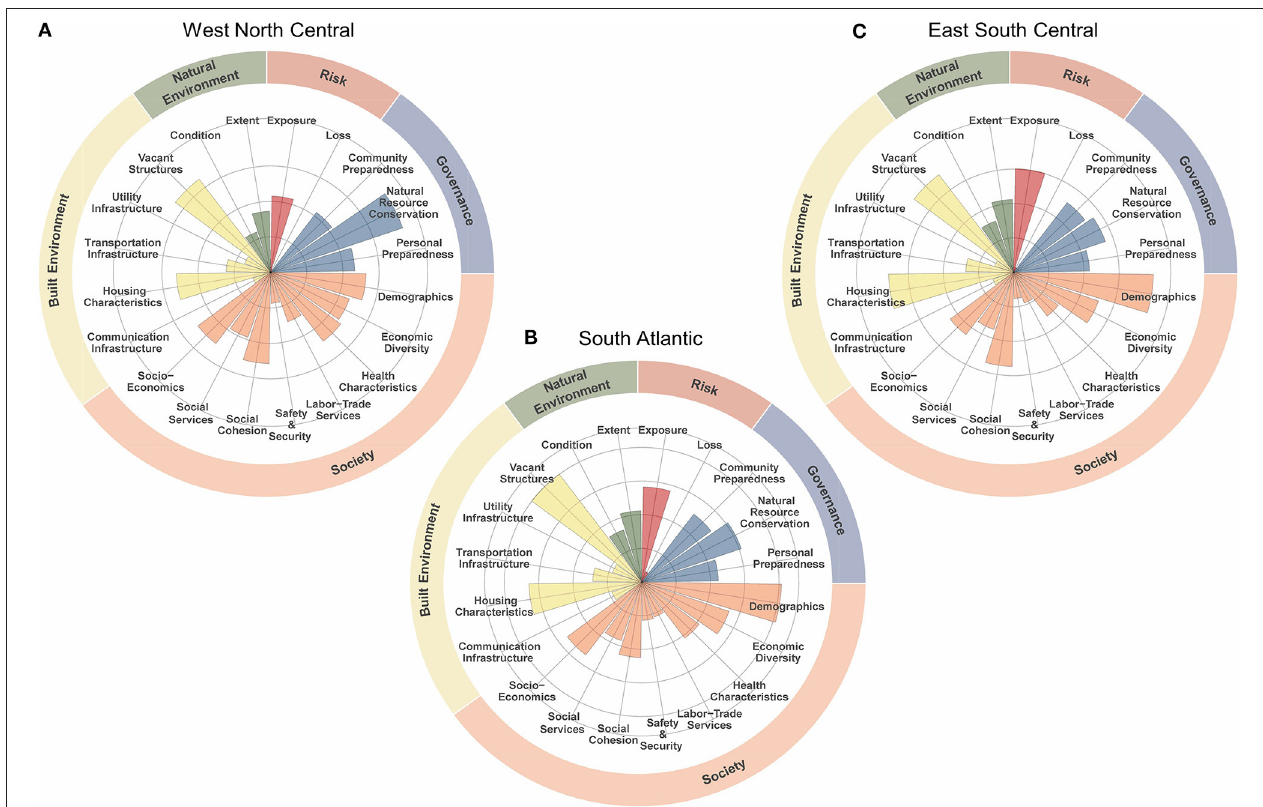
FIGURE 6 | Polar plots of the (A) West North Central, (B) South Atlantic, and (C) East South Central